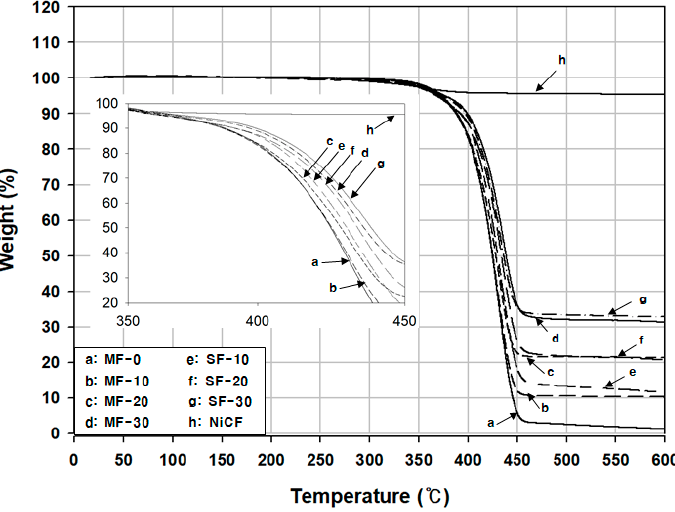
Figure 5. TGA curves of the MF-NiCF/PA6 and SF-NiCF/PA6 pellets with various NiCF